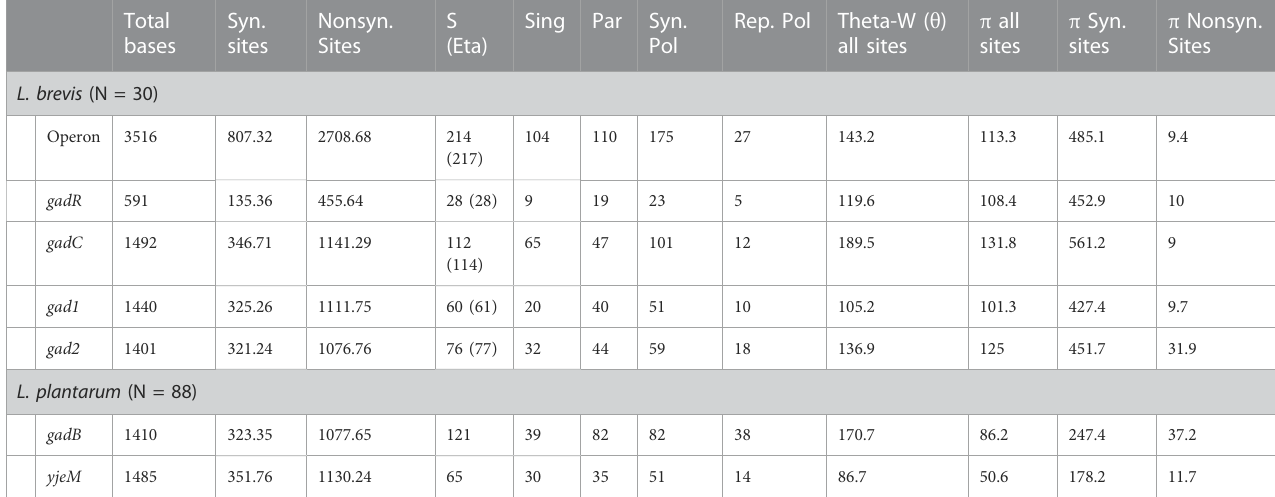
TABLE 1 Nucleotide diversity population genetic summary statistics for glutamate decarboxylase pathway genes in the examined L. brevis and L. plantarum populations. Total bases